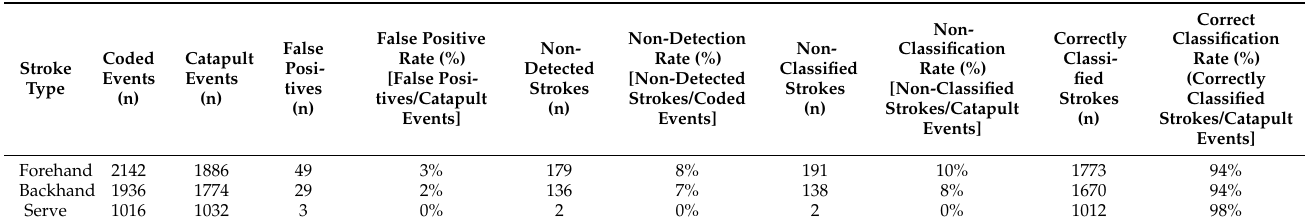
Table 2. Stroke-Level Analysis of Catapult Detected Backhand Strokes vs. Manual Coding.